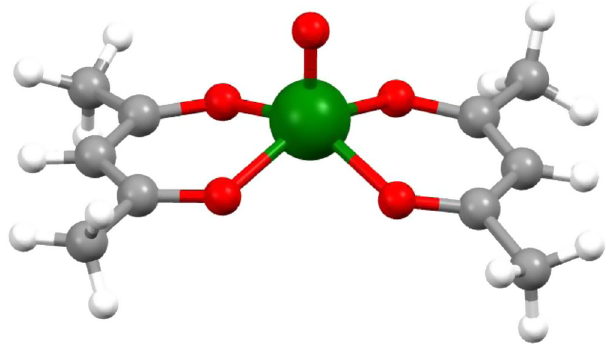
Fig. 1 The [VO(acac) 2 ] molecular qubit. Molecular structure of VO- acetylacetonate (green, V; red, O; grey, C; white, H). The double bond typical of the VO 2 þ moiety is the apical